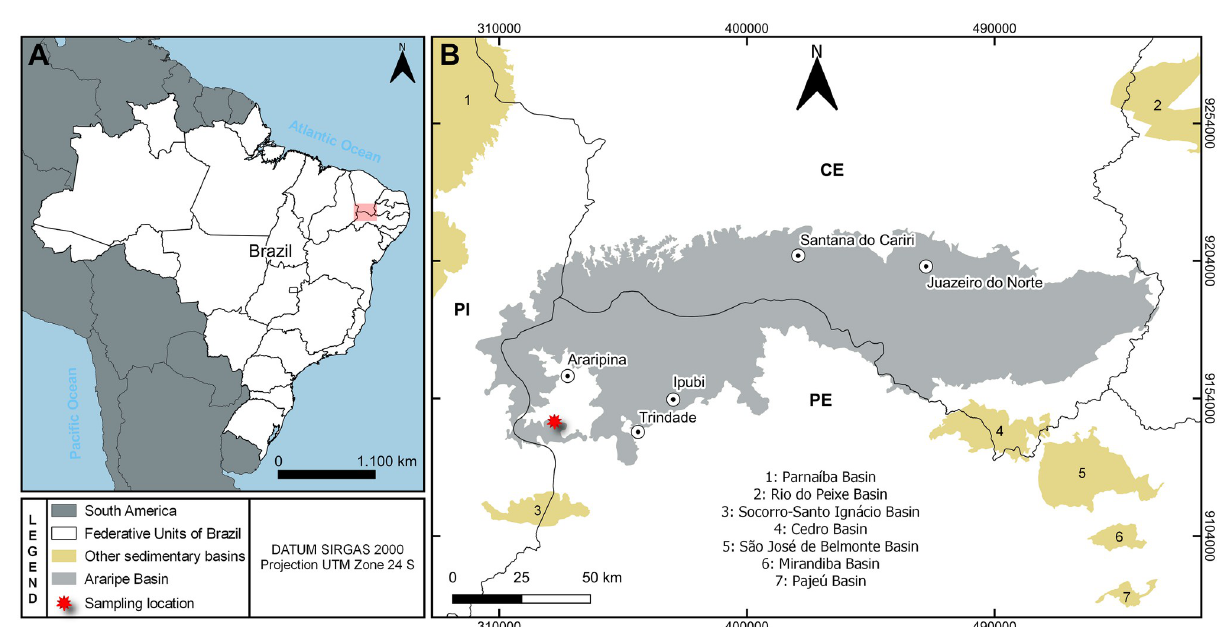
Fig 2. Geographic position of Trindade, Pernambuco, Brazil. Geographic position of the sampling site Trindade in the Araripe Basin, northeast Brazil. Colors indicate the different sequences of the Araripe Basin. Map figures (A) made with Natural Earth, and (B) was obtained from Brazilian Geological Service (CPRM, at https://geoportal.cprm.gov.br/geosgb/) powered by ESRI.